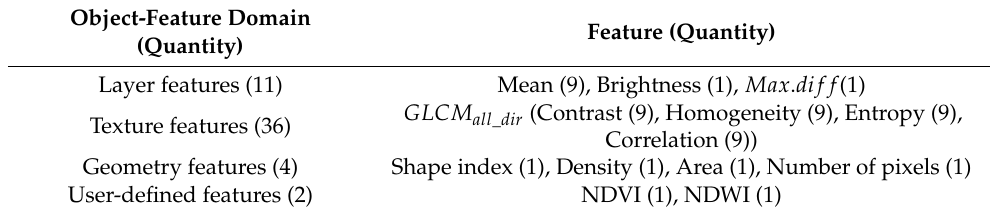
Table 3. Pre-selected features used for